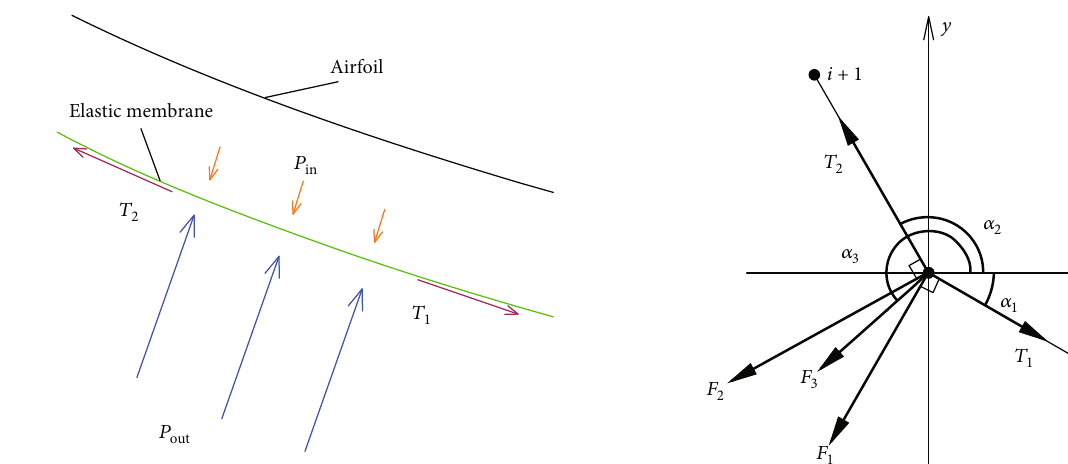
Figure 5: Free body diagram of the elastic membrane node i .